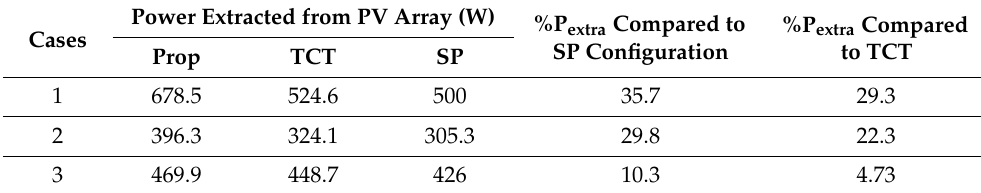
Table 1. Report card of power output of the proposed scheme .